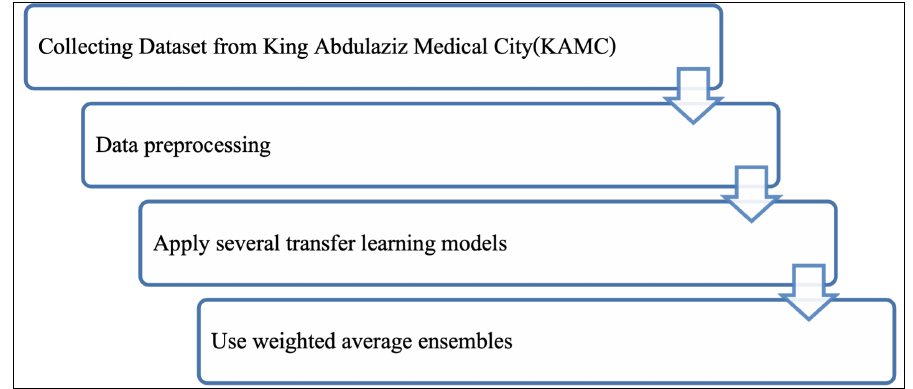
Figure 4. Methodology.